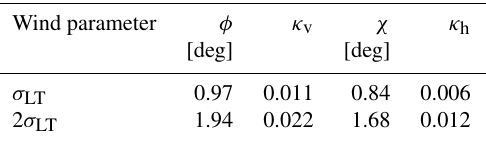
Table 2. Lifetime standard deviation and 2 σ bounds of the estima- tion error for the wind